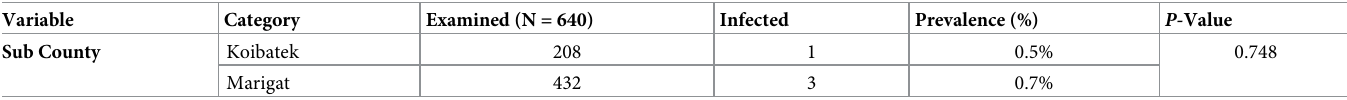
Table 1. Sero-prevalence of brucellosis among livestock keepers in Baringo